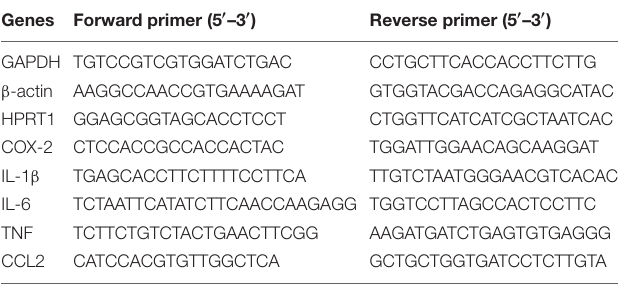
TABLE 1 | Primers employed for quantitative real-time polymerase chain reaction (qRT-PCR) and their corresponding sequences. Genes Forward primer (5 (cid:48) –3 (cid:48) ) Reverse primer (5 (cid:48) –3 (cid:48)